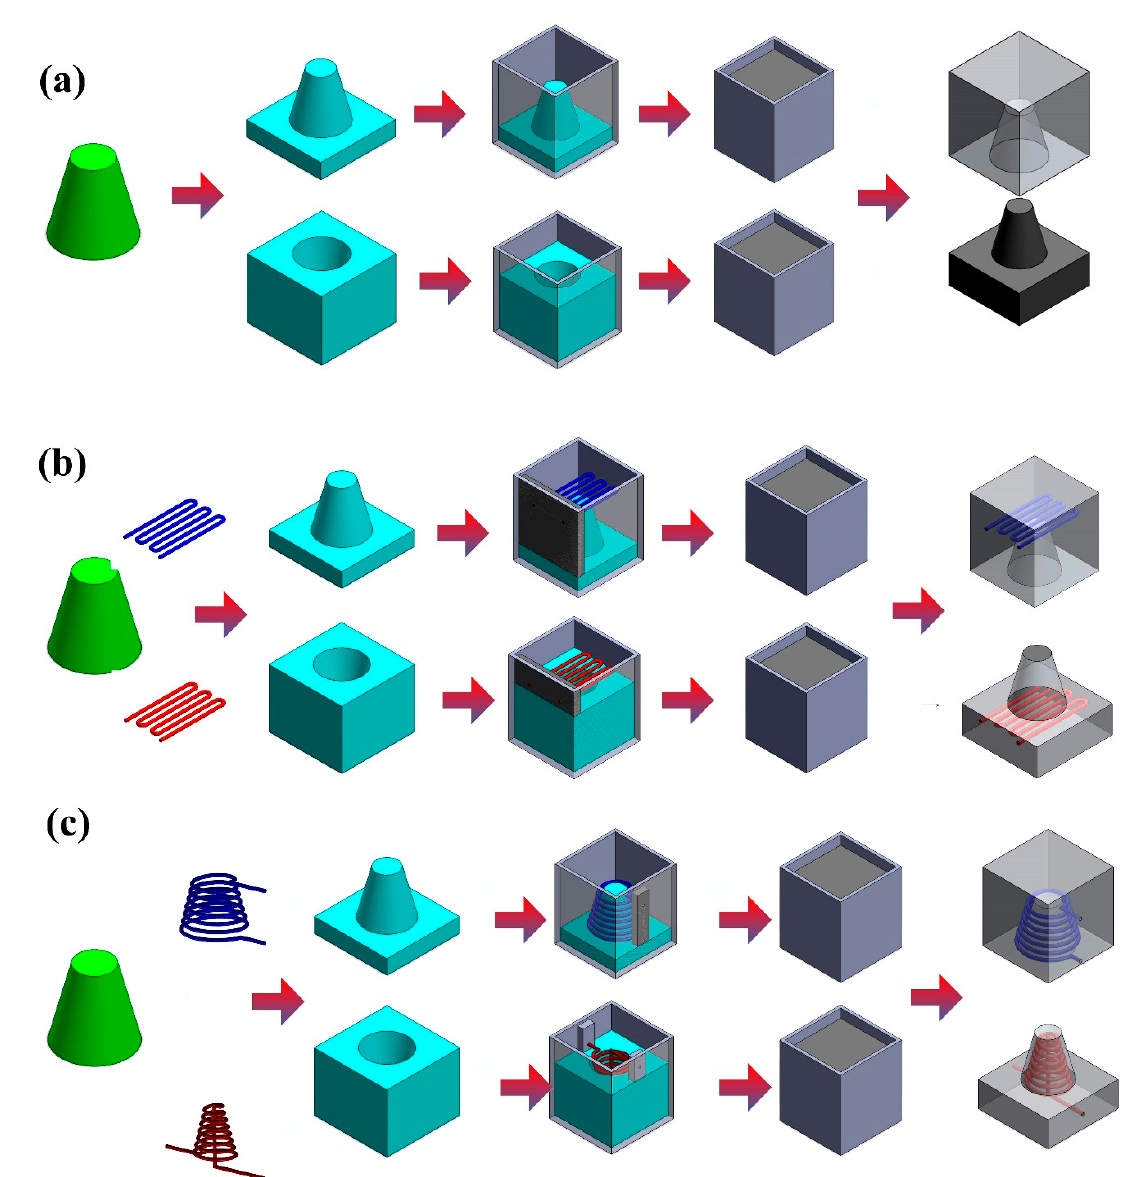
Figure 5. Process layouts for fabricating three different kinds of injection molds ( a ) without cooling channels, ( b ) with conventional cooling channels, and ( c ) with conformal cooling channels.